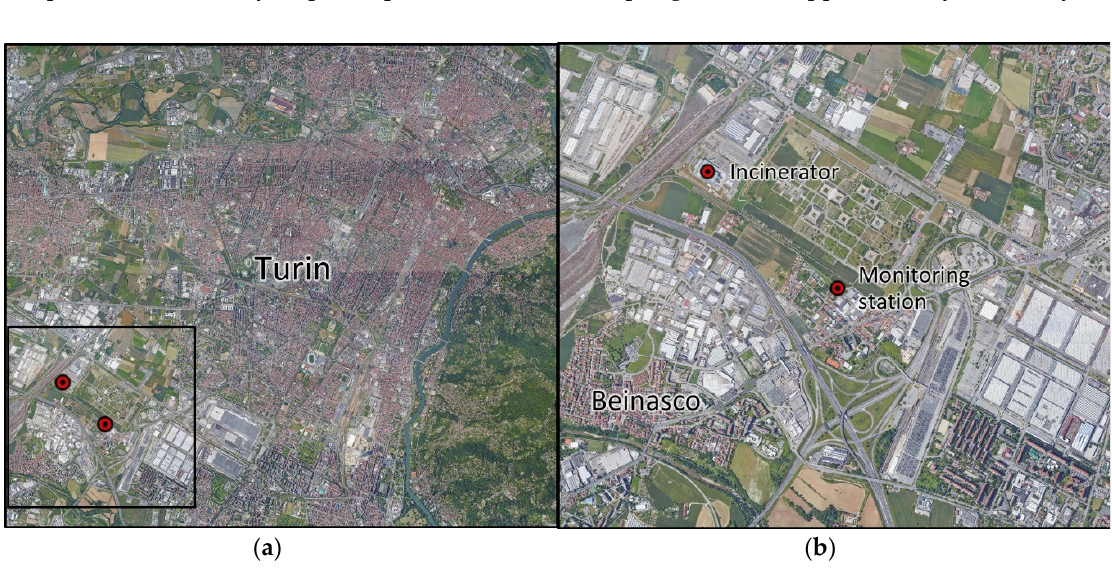
Figure 1. Google Earth maps showing the position of the incinerator and the monitoring station: ( a ) Turin metropolitan area; ( b ) zoom of the investigated site.